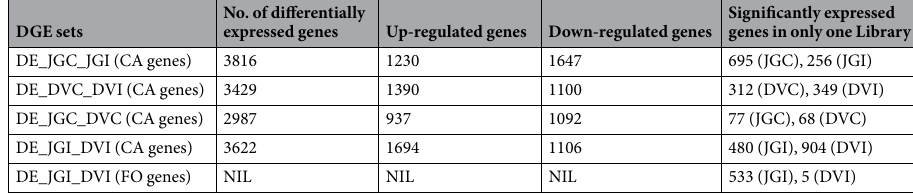
Table 2. Differential gene expression analysis. Differential Gene Expression (DGE) Sets represent comparisons among the four SAGE libraries. For example, DE_JGC_JGI shows DEGs up- or down-regulated in JGI compared to JGC. CA stands for Cicer arietinum (chickpea) and FO stands for Fusarium oxysporum